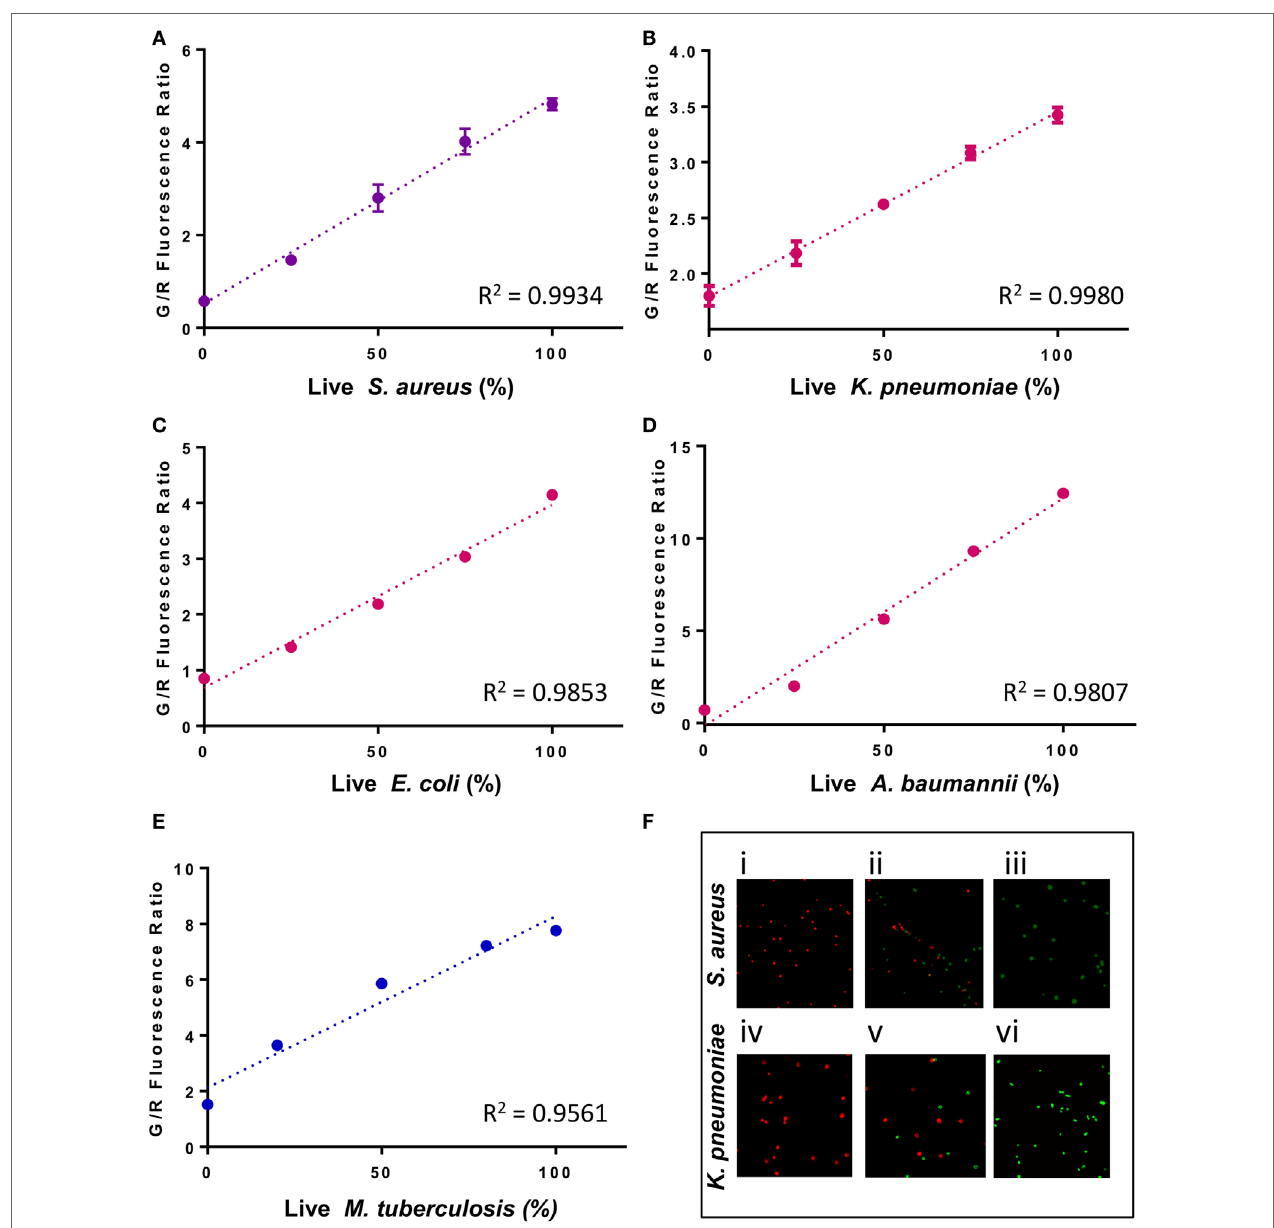
FigUre 1 | A linear relationship between the percentage of live cells and the green/red fluorescence ratio from the SYBR Green I/propidium iodide (PI) viability assay for different bacterial species. Known proportions of isopropyl killed (30 min) and live (a) Staphylococcus aureus (USA300), (B) Klebsiella pneumoniae (Isolate 7), (c) Escherichia coli (W3110), (D) Acinetobacter baumannii , and (e) Mycobacterium tuberculosis (H37Ra) were stained with SYBR Green I/PI and measured using a fluorescence plate reader. A linear regression line was determined. (F) Fluorescence microscopy image showing known proportions (0, 50, and 100%) of live (i–iii) S. aureus (USA300) and (iv–vi) K. pneumoniae (isolate 7) stained with SYBR Green I/PI reveal red (dead) and green (live) ratios in concordance with the known proportions of live and killed organisms from representative Gram-positive ( S. aureus ) and Gram-negative ( K. pneumoniae ) bacteria. Data represent the means ±